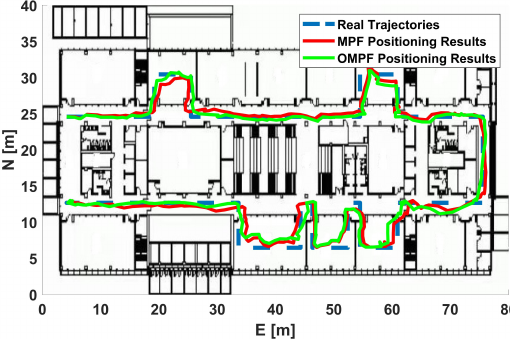
Figure 5: Navigation solutions of MPF and OMPF